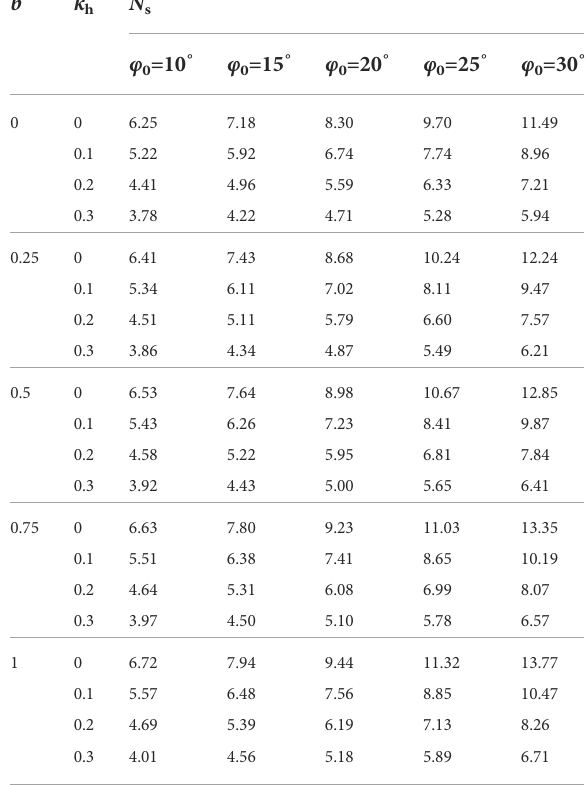
Figure 5D, under the conditions of φ 0 =20 ° , b=0.5, and k h =0.2,